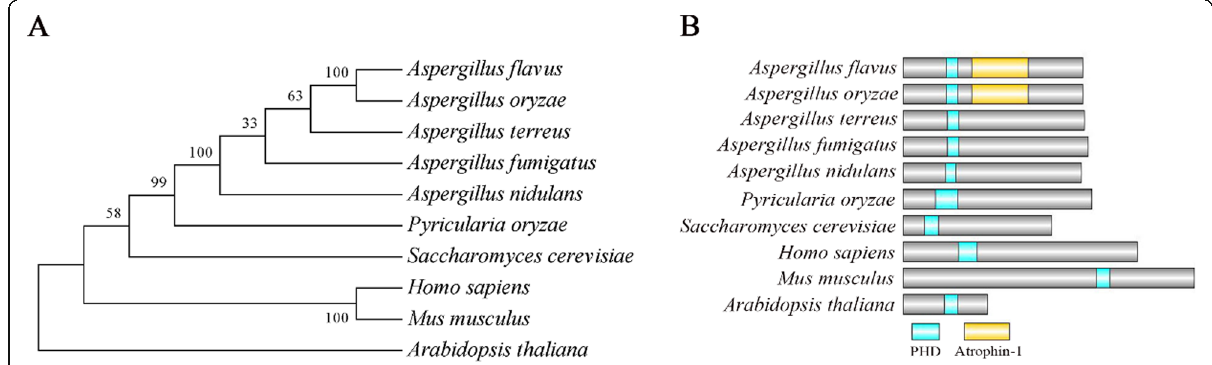
Fig. 1 Bioinformatics analysis of Cti6. a The construction of phylogenetic relationship among 10 Cti6 homologs (from A. flavus , A. oryzae , A. terreus , A. fumigatus , A. nidulans , P. oryzae , S. cerevisiae , H. sapiens , M. musculus and A. thaliana ) with MEGA5.0. b The domains of Cti6 from above 10 species were identified through NCBI, and the domains were further visualized by DOG2.0